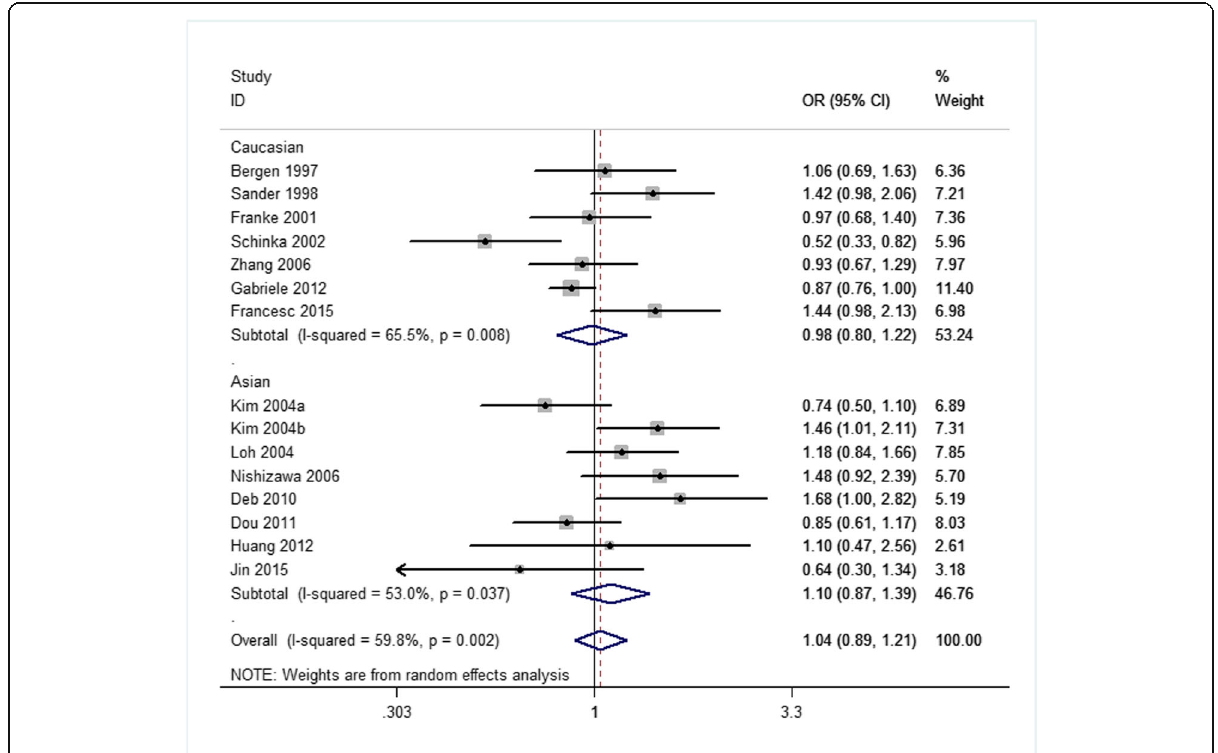
Fig. 3 Forest plots (individual and pooled effects with 95% CI) regarding the association of the OPRM1 A118G polymorphism with alcohol dependence in the allele